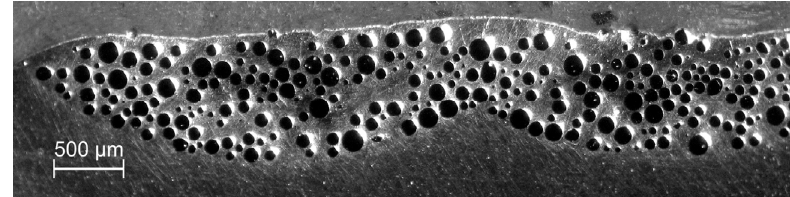
Figure 6. Cross-section of the multi-trace MMC Al6061 + WC p surface layer; experimental conditions: I = 260 W/mm 2 , ν sc = 10 mm/s, m p = 30 g/min.